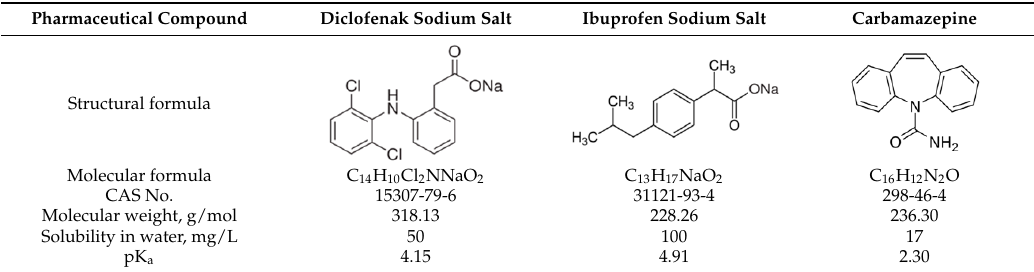
Table 1. Characteristics of tested pharmaceutical compounds.